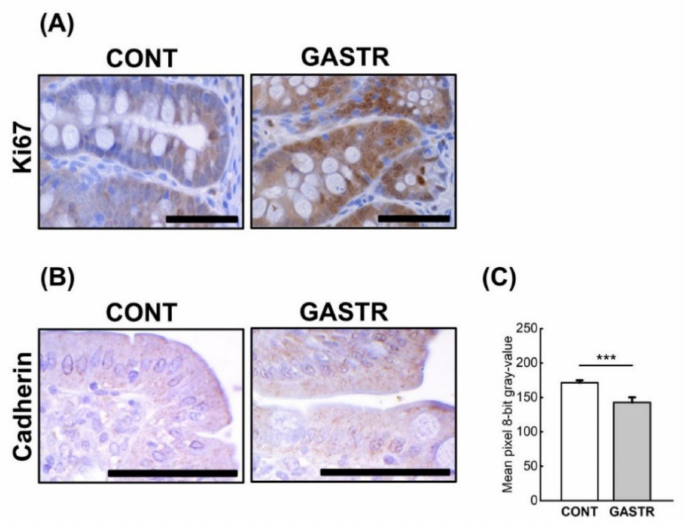
Figure 4. ( A ) Representative photomicrographs of the immunohistochemical reactions for Ki-67 in the jejunum. ( B ) Representative pictures of the immunohistochemical reactions for cadherin in the sections of the jejunum. Sections were developed in 3,3 (cid:48) -diaminobenzidine tetrahydrochloride (DAB); counterstaining was performed with Mayer’s hematoxylin. All the scale bars represent 50 µ m. ( C ) The intensity of expression of cadherin in the jejunum, measured by the quantitative assessment of mean pixel intensity values in the photomicrographs converted to 8-bit grayscale images. The scale was from 0 (white pixel) to 255 (black pixel); the lower the pixel value, the higher the intensity of immunohistochemical reaction. Graph shows mean ± standard error. Significance was established using a two-tailed Student’s t -test (normally distributed data), Welch’s test (normally distributed data with unequal variances) or the Mann–Whitney test (for pairwise comparisons with at least one non-normally distributed dataset); *** p < 0.001. Table 2. The histomorphometrical parameters of the enteric nervous plexuses in the duodenum and jejunum of the male Wistar rats in the CONT (sham-operated) and GASTR (subjected to gastrectomy) groups.